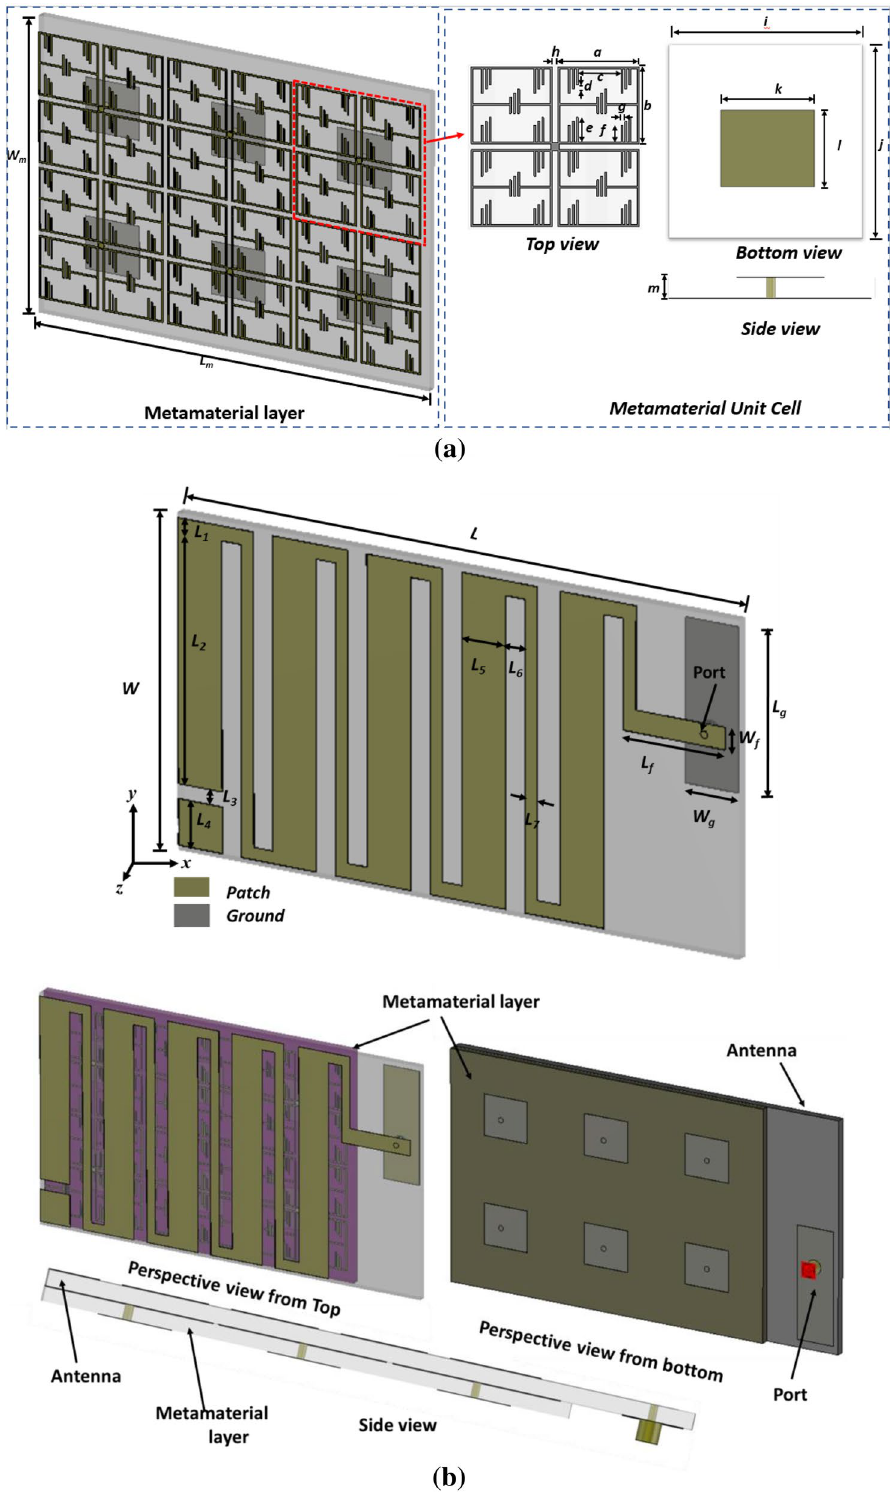
Figure 1. ( a ) NZIM Metamaterial layout configuration and ( b ) design layout of the optimized antenna. (CST STUDIO SUITE 2019, https:// www. 3ds. com/ produ cts- servi ces/ simul ia/ produ cts/ cst- studio- suite) 16